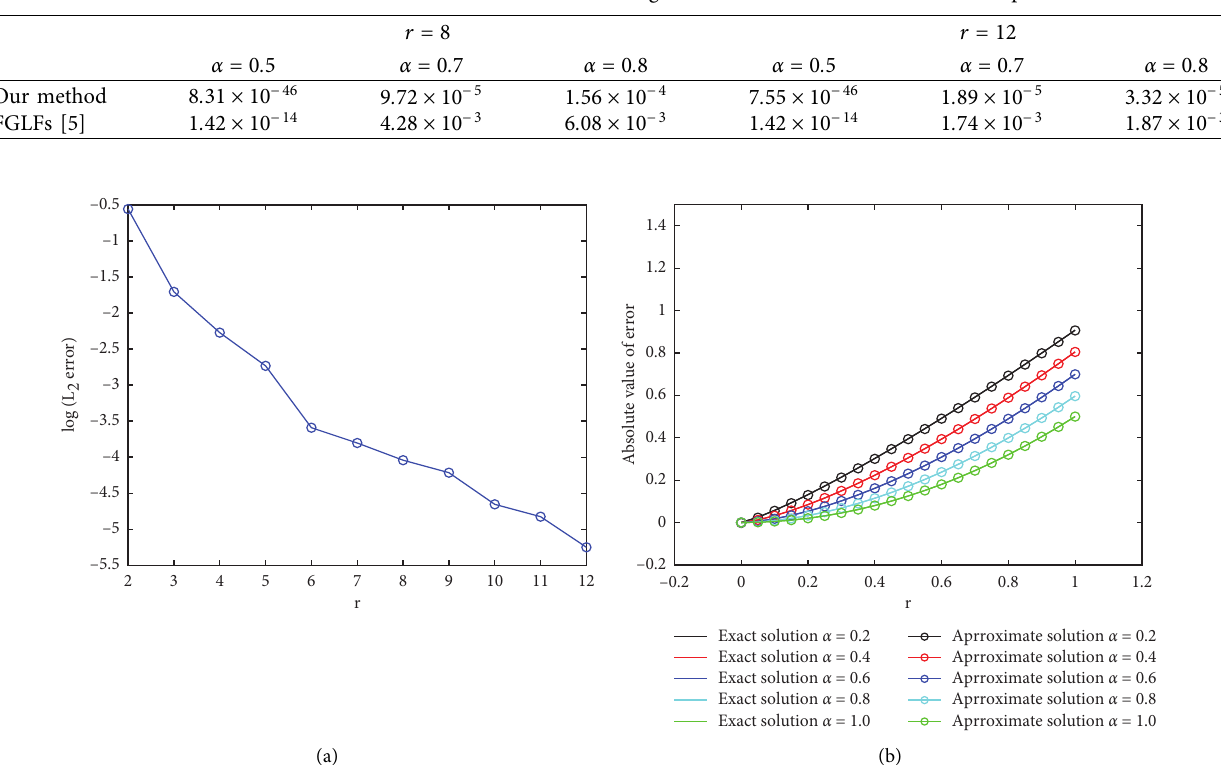
Figure 1: Plot of L 2 –errors taking different vales for r (a) and absolute value of error for different values of α (b) for Example